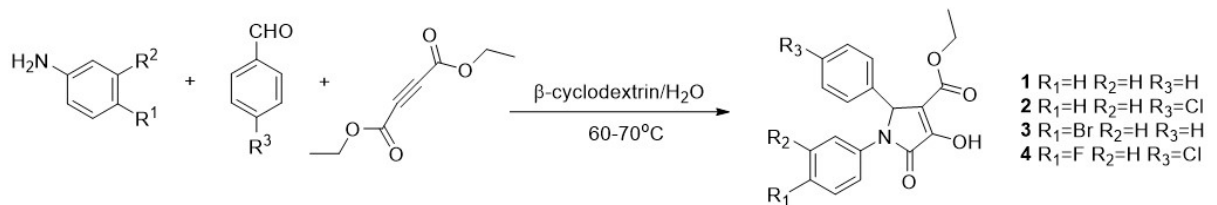
Figure 1. Synthesis of 1 – 4 halogen pyrrolidones. Conditions. To an aqueous solution of β -cyclodextrin an aniline derivative was added. Subsequently, diethyl acetylenedicarboxylate was added slowly followed by an aromatic aldehyde. The reaction mixture was heated at 60–70 °C.